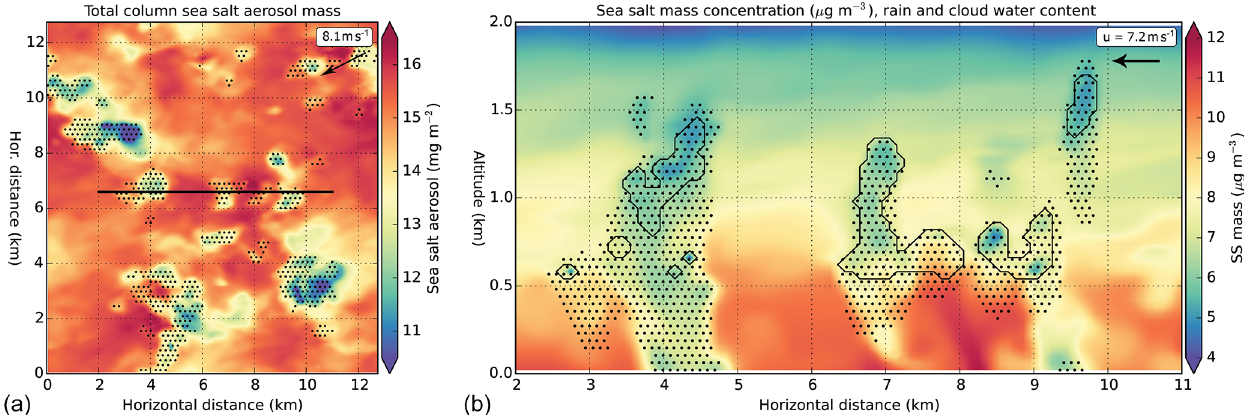
Figure 3. (a) Instantaneous horizontal cross sections of the cloud and aerosol spatial distribution at t = 5 . 5h. Occurrence of clouds and precipitation is indicated by the hatching. The underlying colour scale indicates sea salt aerosol mass concentration. Average wind speed and direction in the cloud layer (500–2000m) is denoted in the top-right corner. The black line indicates the vertical cross section shown in the right panel. (b) Vertical cross section of sea salt aerosol concentration, with cloud (outline) and precipitation (hatching) indicated separately. Arrow in the top right corner indicates the zonal component of the